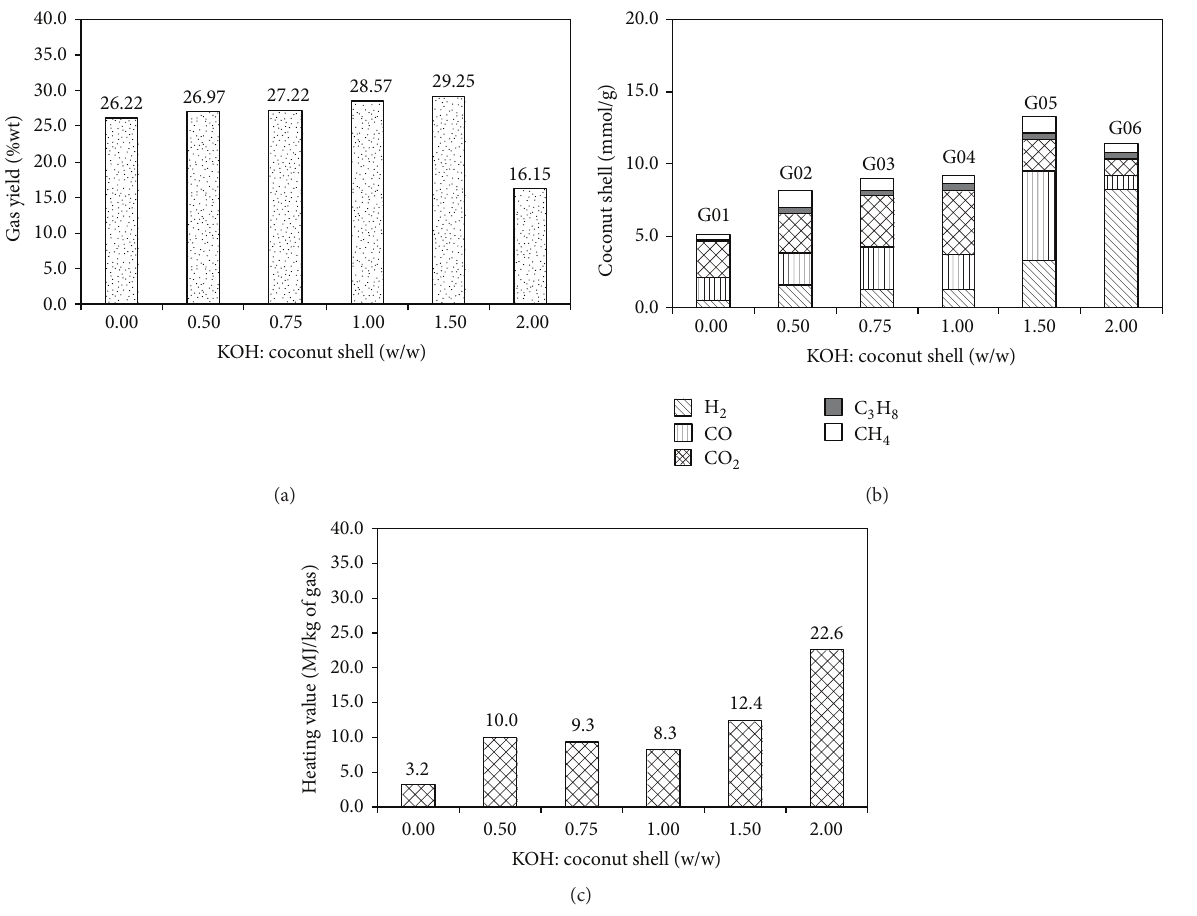
Figure 2: Effect of chemical weight ratio on (a) production yield, (b) composition, and (c) heating value of gas products from gasification of coconut shell with CO 2 and KOH at 600 ∘ C for